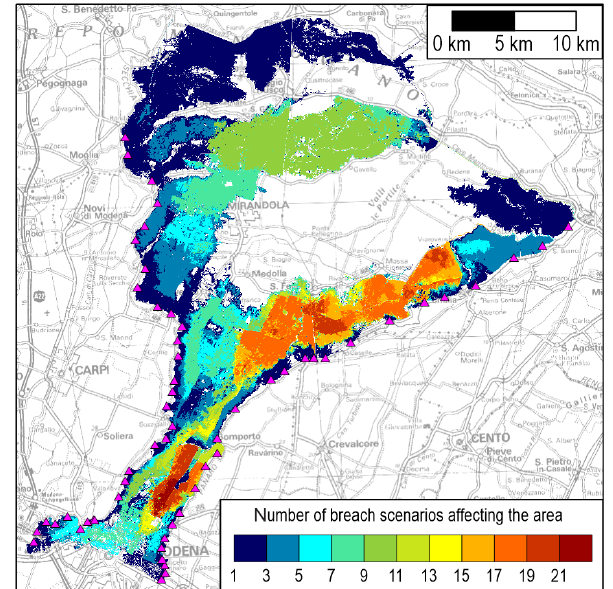
Figure 4. Number of flooding scenarios affecting each cell of the pilot area with inflow B. Two portions of the domain (in red) are flooded for 21 scenarios (from either the Secchia or the Panaro River), while the uncoloured zones are never inundated. The topo- graphic map in background is made available by Emilia-Romagna region at https://geoportale.regione.emilia-romagna.it/it (last ac- cess: 8 January